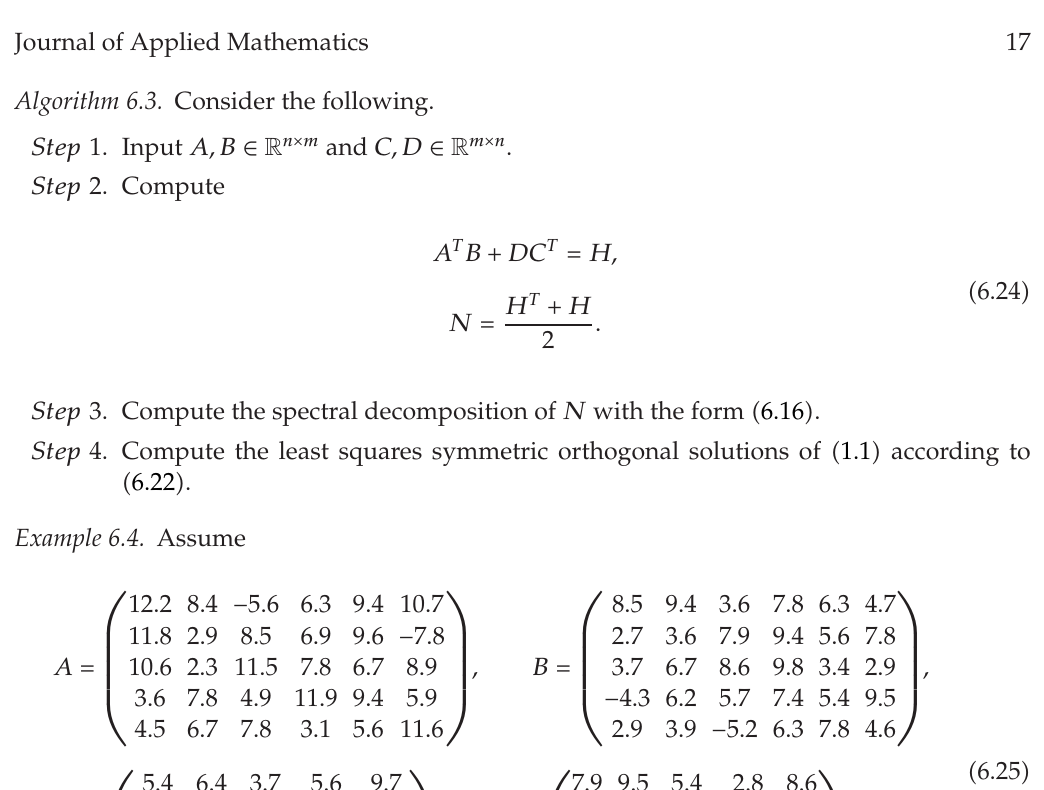
Algorithm 6.3. Consider the